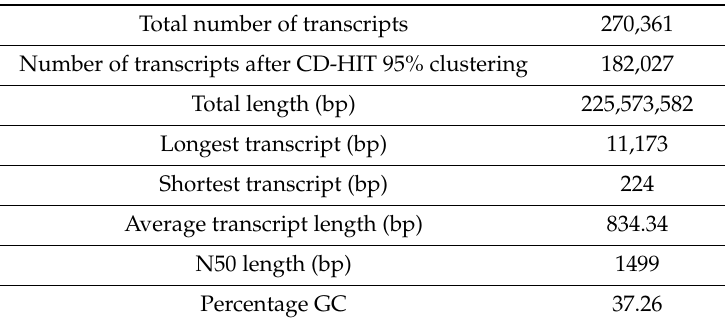
Table 2. Summary of the P. lividus transcriptome assembly.